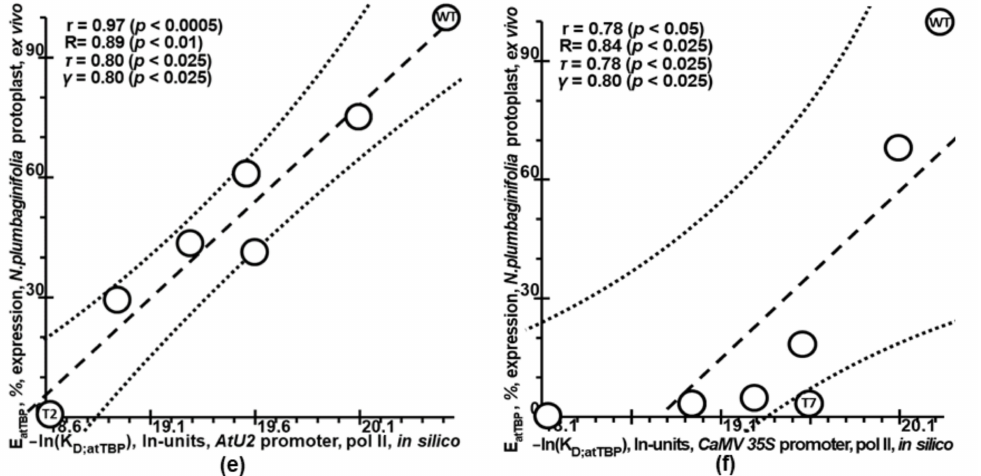
Figure 4. Verification of Plant_SNP_TATA_Z-tester using experimental data on the natural plant promoters (datasets 3–8). ( a ) The rice gene PAL promoter (phenylalanine ammonia-lyase) and Pol II, in whole-cell extracts of rice cell suspension cultures in vitro [46,47]. ( b , c ) The bean tRNA-Leu gene prompter, Pol III, in vitro [48] and ex vivo [49], respectively. ( d ) The thale cress U6-26 snRNA gene promoter (U6 small nuclear RNA; TAIR ID AT3G13855 [57]) and Pol III [50]. ( e ) The thale cress U2.2 snRNA gene promoter (U2 small nuclear RNA; TAIR ID AT3G57645 [57]). ( f ) The cauliflower mosaic virus (CaMV) promoter for the viral 35S transcript (GenBank AC MT611510 [58]), ( e , f ) RNA polymerase II. ( d – f ) Tobacco protoplasts ex vivo [50]. The natural (WT) and one of the mutant variants of the promoter under study are indicated.